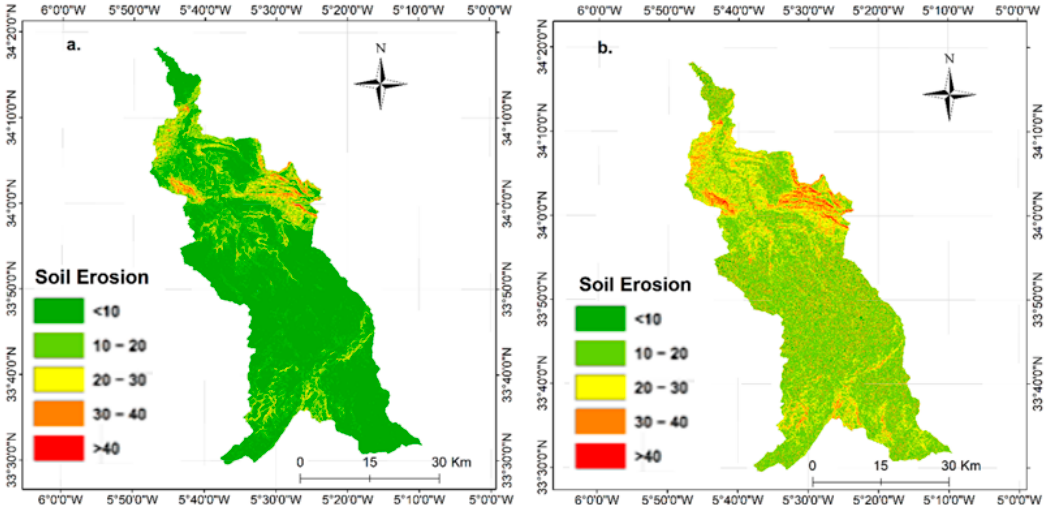
Figure 8. Soil erosion rate for using RUSLE model ( a ) for the period 2000–2013, ( b ) for the period 2014–2027. Table 6. Soil erosion classes with area occupied using RUSLE